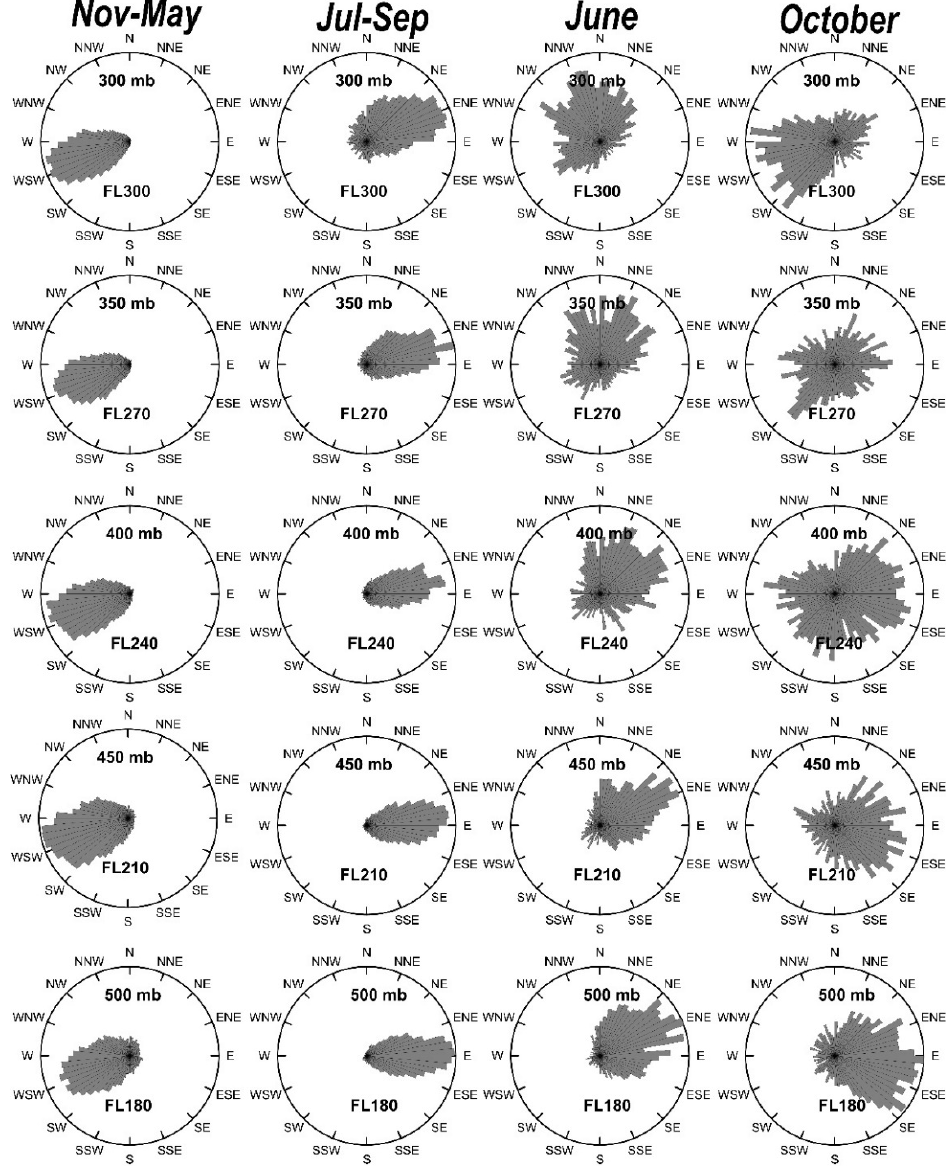
Figure 4. Wind rose diagrams over the crater of the Popocatepetl volcano. Data were obtained from NOAA re-analysis data for a period of 20 years, at pressure levels of 500 to 300 mb. Wind data were statistically analyzed separately for each month of the year, associating the trends in the months of the year. Wind data were statistically analyzed using a wind rose or circular histograms, with tertiary intercardinal directions (32 directions). The data were separated by months of the